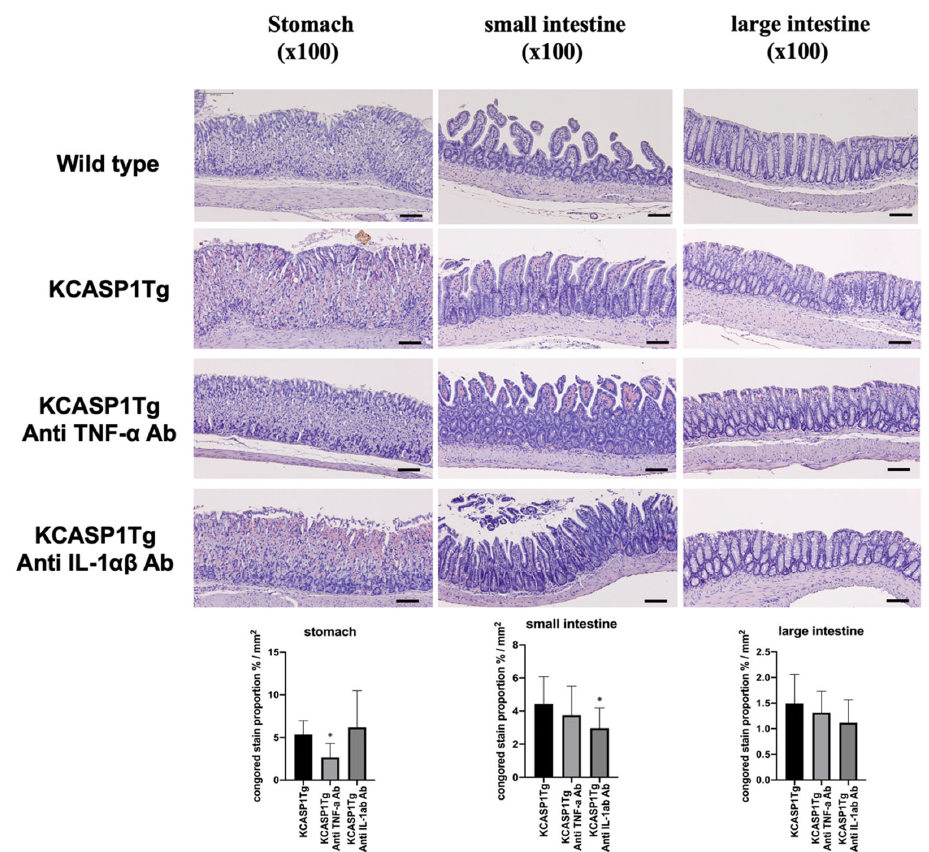
Figure 5. The effect of anti ‐ TNF ‐α and IL ‐ 1 α / β in the KCASP1Tg mice. KCASP1Tg mice were treated with neutralizing antibodies against TNF ‐α or IL ‐ 1 α / β to prevent gastrointestinal amyloidosis, and the Congo red stain ‐ positive area was partially ameliorated in the stomach and small intestine. Scale bar = 50 μ m. * p < 0.05 compared to wild mice by Kruskal–Wallis test.